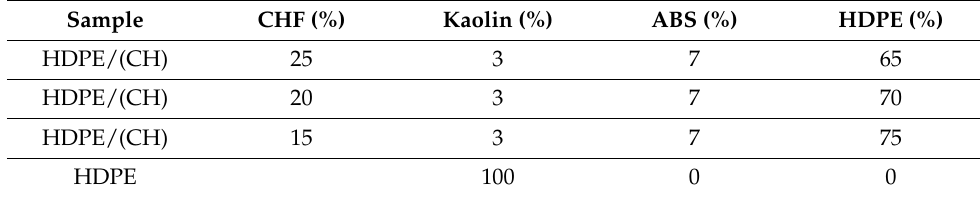
Table 1. Formulations for the composites according to the weight percentage